Question: Provide a one-line summary of what is displayed.
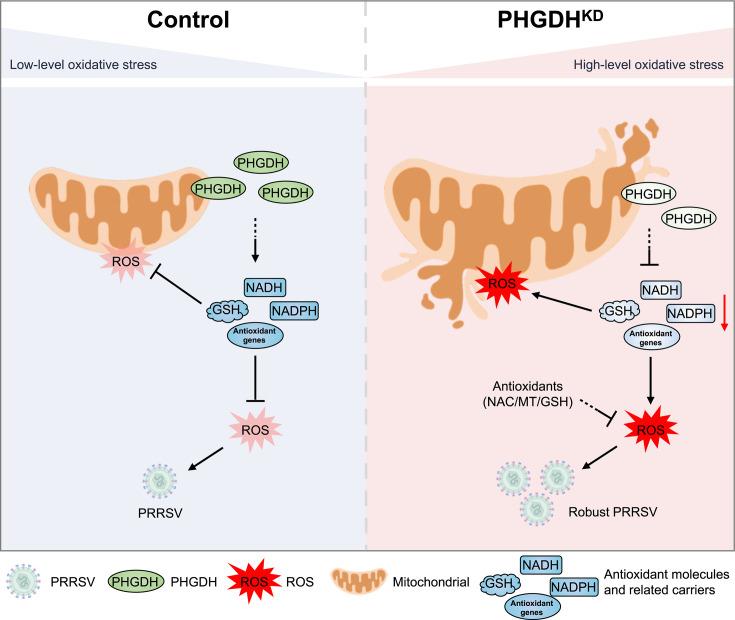
Answer: A model of the PHGDH–redox axis in PRRSV infection. Schematic summarizing the proposed mechanism: in control cells, PHGDH supports antioxidant gene programs and maintains reducing equivalents (GSH, NADH, and NADPH) to limit ROS/mROS, thereby restraining PRRSV replication. Upon PHGDH depletion, antioxidant genes and reducing equivalents decline, ROS/mROS accumulate, and PRRSV replication is enhanced.